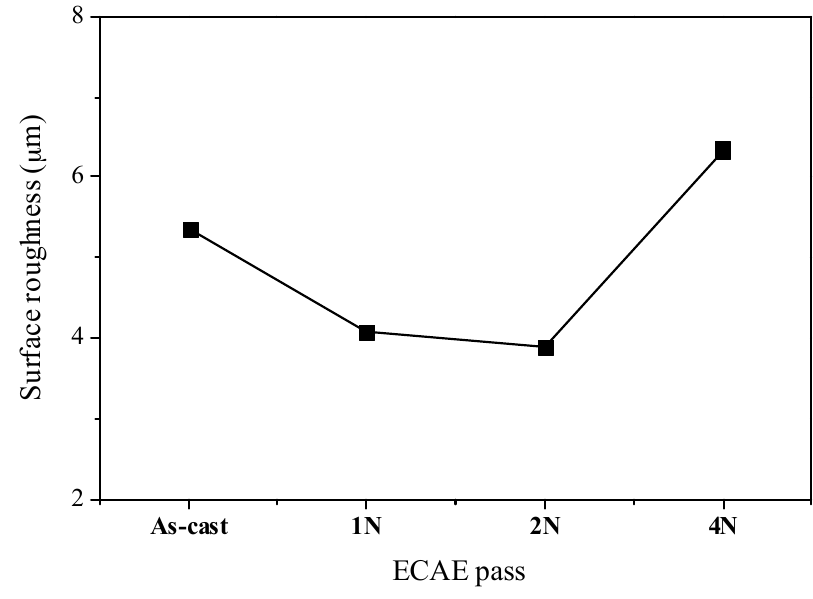
Figure 6. The surface roughness of the as-cast and ECAE-processed Mg-Sn alloys after the wear test.